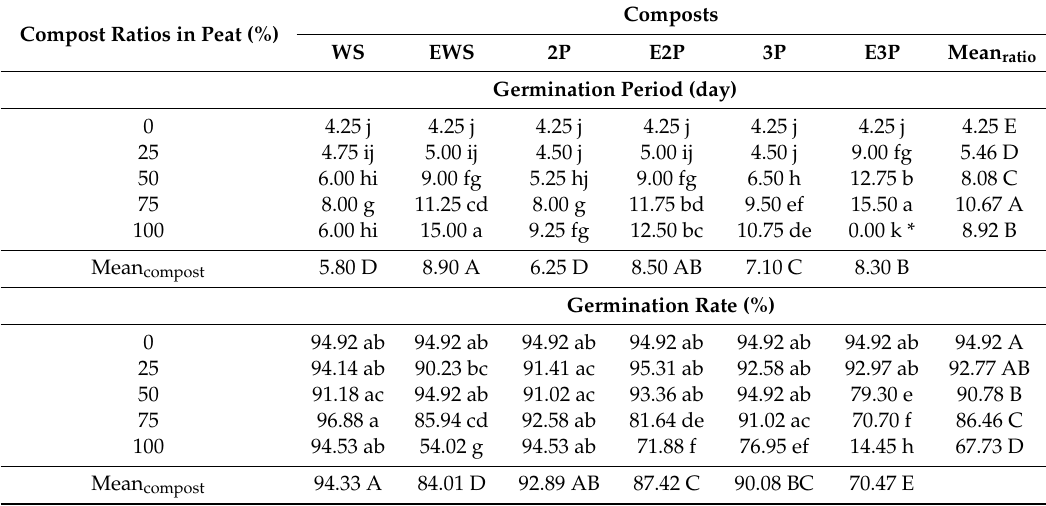
Table 5. E ff ects of composts with local peat on germination period and the rate of Solanum lycopersicum . Compost Ratios in Peat